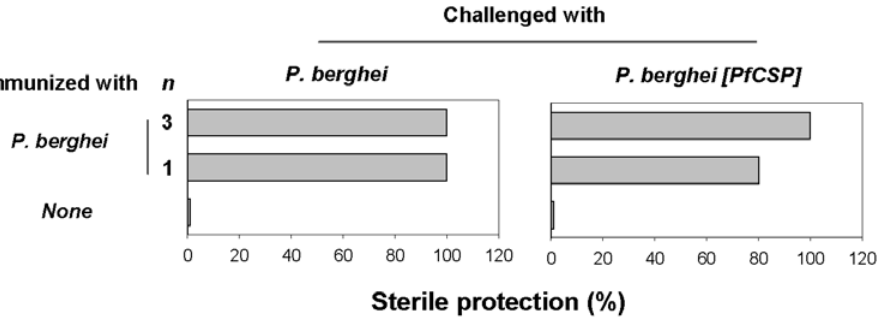
Figure 4. Sterile protection in mice immunized with P.bergheiirradiated sporozoites and challenged with P.bergheior P.berghei[PfCS] sporozoites. Mice were immunized with 1 or 3 injections of P. berghei (indicated on the left of the panel) before challenge with 5 000 P. berghei or P. berghei [ PfCS ] sporozoites. All naive control mice developed a patent blood-stage infection. The data are representative of those obtained in duplicate experiments.